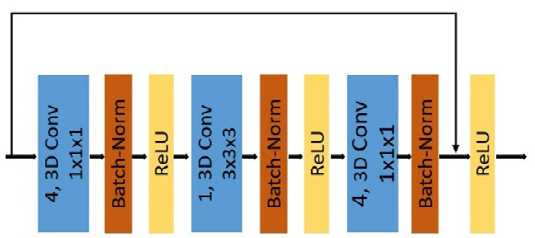
Figure 3. The overview of 3D_ResNet architecture. This figure showed the number of feature map, kernel size of the 3D convolutional layer (3D Conv), batch normalization layer (Batch-Norm), and Rectified-Linear unit layer (ReLU).